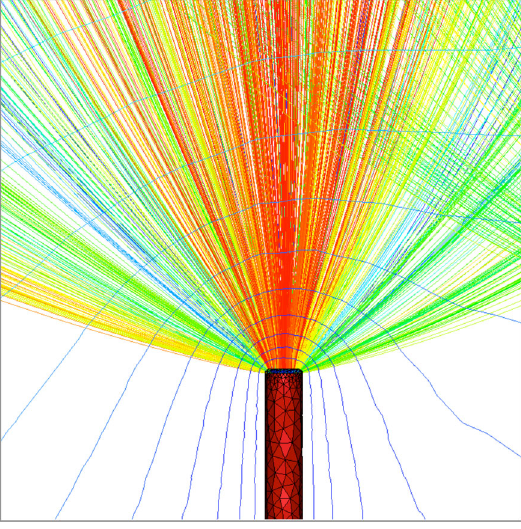
FIG. 19. Close-up of the emission region of the simulation shown in Fig. 18.